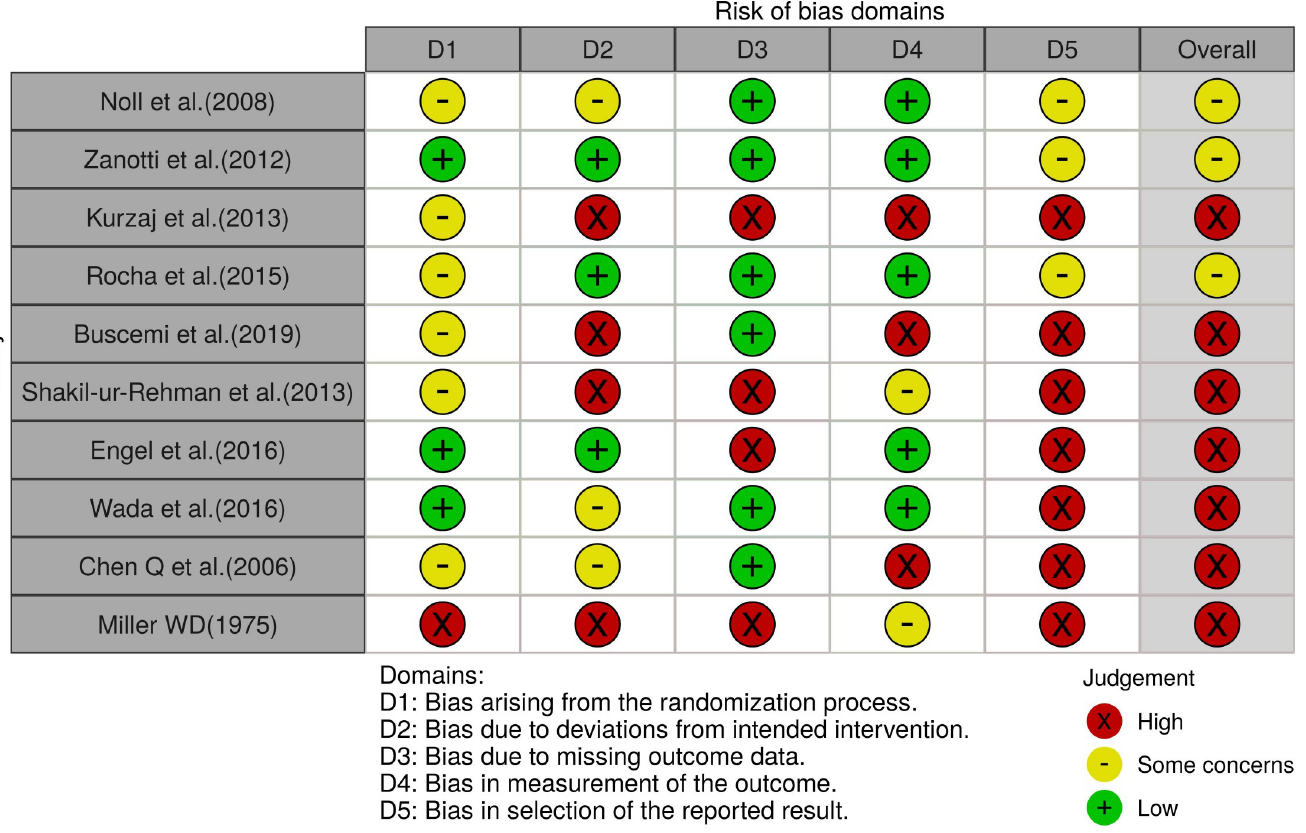
Fig 2. Summary of risk of bias based on analysis of the crossover trials using the Cochrane RoB 2.0 tool.